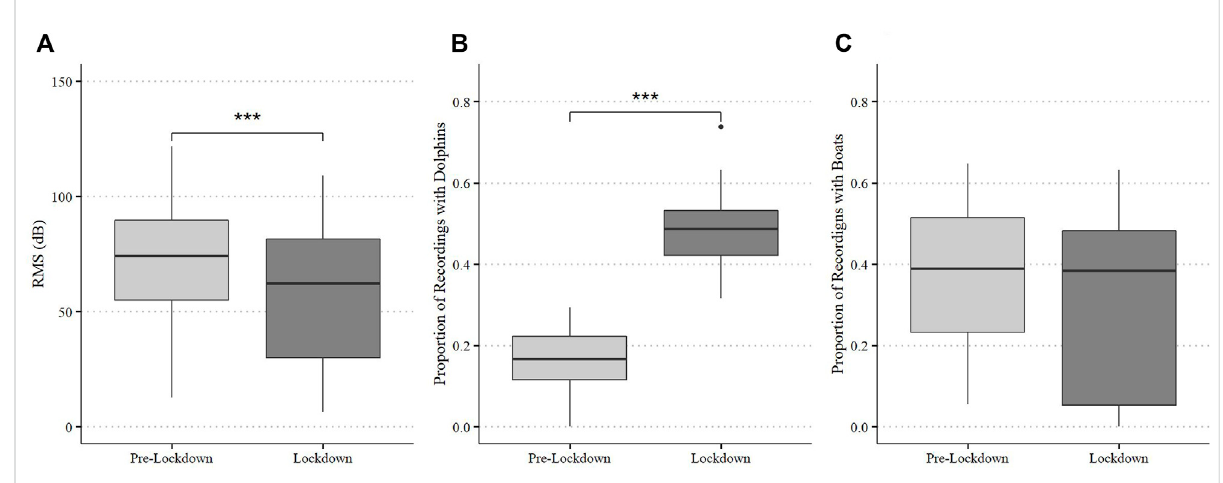
FIGURE 2 Broadbandambientnoise levels (RMSdB) (A) and proportion of recordings containingdolphin (B) and boat (C) detections atDolphinBayduring pre-lockdown and lockdown. Box plots display medians, fi rst and third quartiles, as well as standard